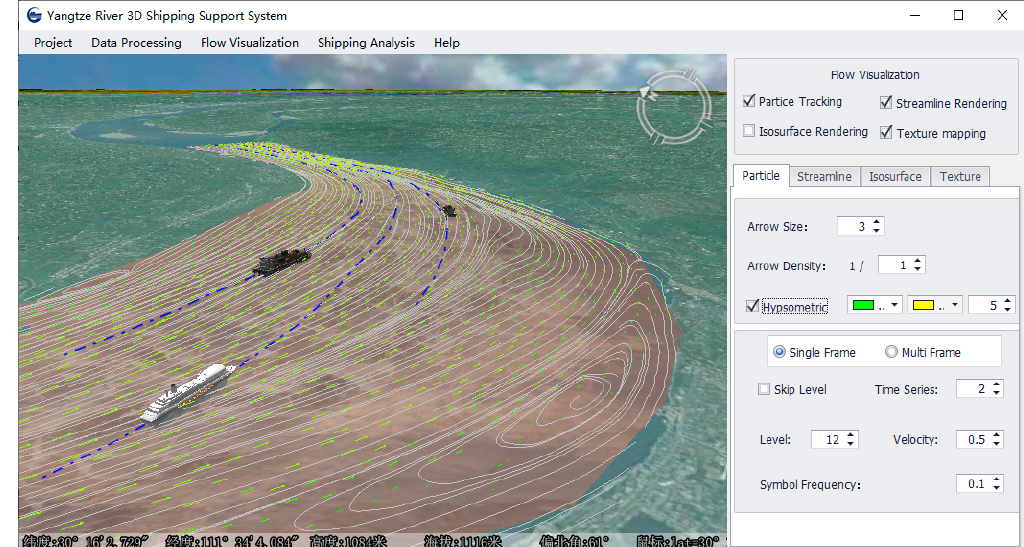
Figure 14. Real-time shipping state analysis (combining particle tracking, streamline rendering, and texture mapping). and texture mapping).